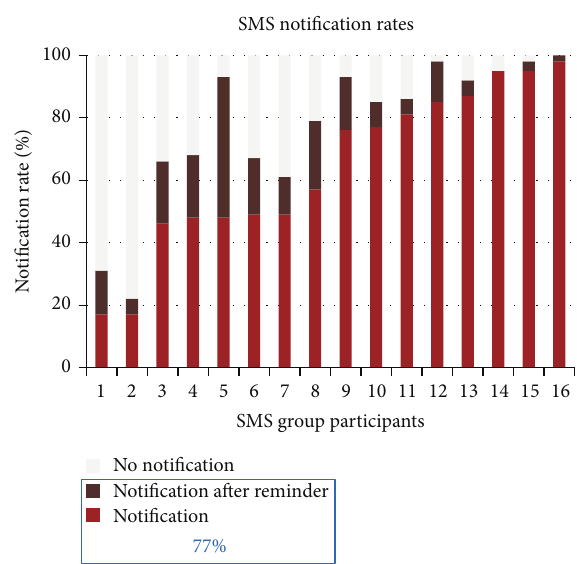
Figure 2: SMS notification rates in access to mobile phone.